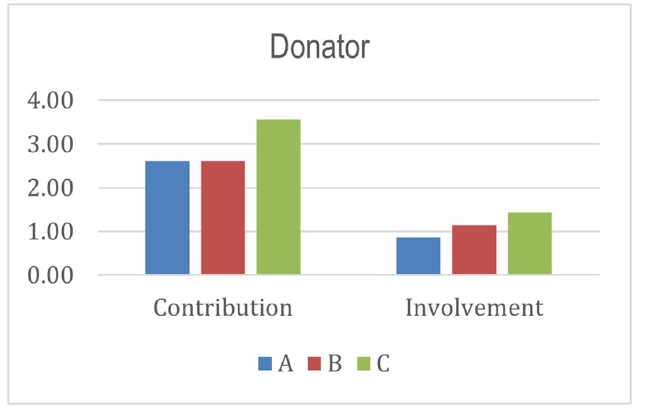
Fig 5. Index score of